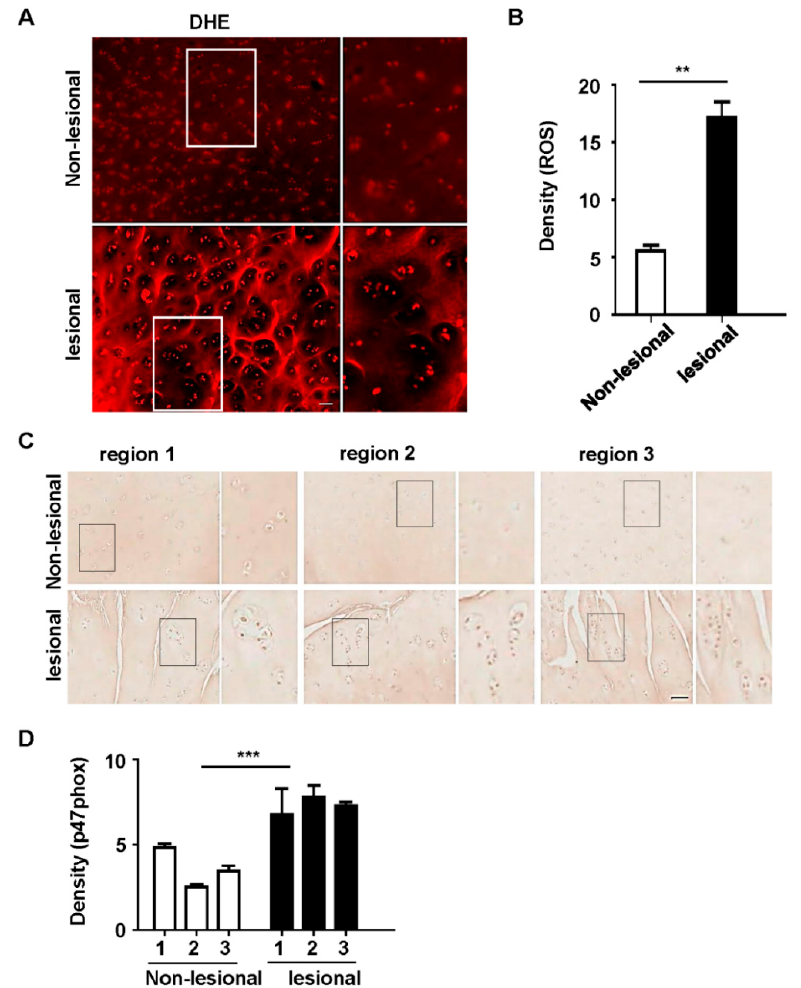
Figure 1. Reactive oxygen species (ROS) production and p47phox expression increased in the articular cartilage of human osteoarthritis (OA) knee joints. ( A ) Representative images of ROS-dependent dihydroethidium (DHE) fluorescence in human OA knee joints. ( B ) DHE staining density measured by using ImageJ software. ( C ) p47phox exhibited prominent expression at lesional sites, compared to non-lesional sites; immunohistochemical analyses show the expression levels of p47phox in knee cartilage at different sites. ( D ) p47phox immunostaining density quantified by ImageJ software; scale bar = 50 µm.